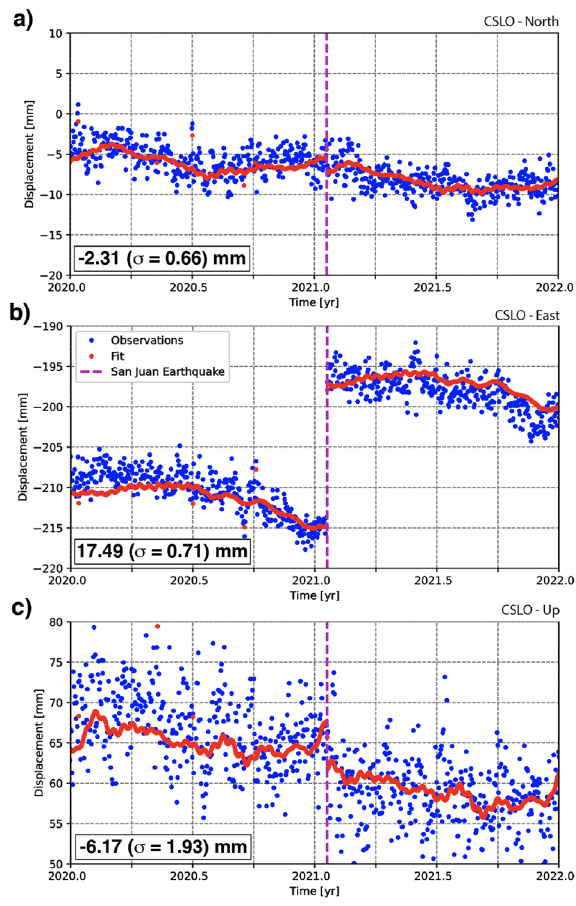
Figure 4. GNSS displacements recorded at station CSLO (see Fig. 2 for location) for years 2020 and 2021. The blue dots represent detrended measurements; red dots show the trajectory model (see text for description and interpretation). Consistent displacement along all three (north, east, and up) components is traceable to the date/time of the 2021 San Juan